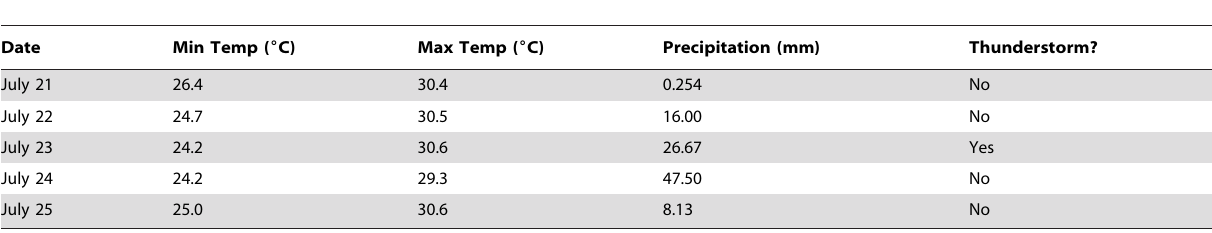
Table 2. Kwajalein Weather Data, July 21–25